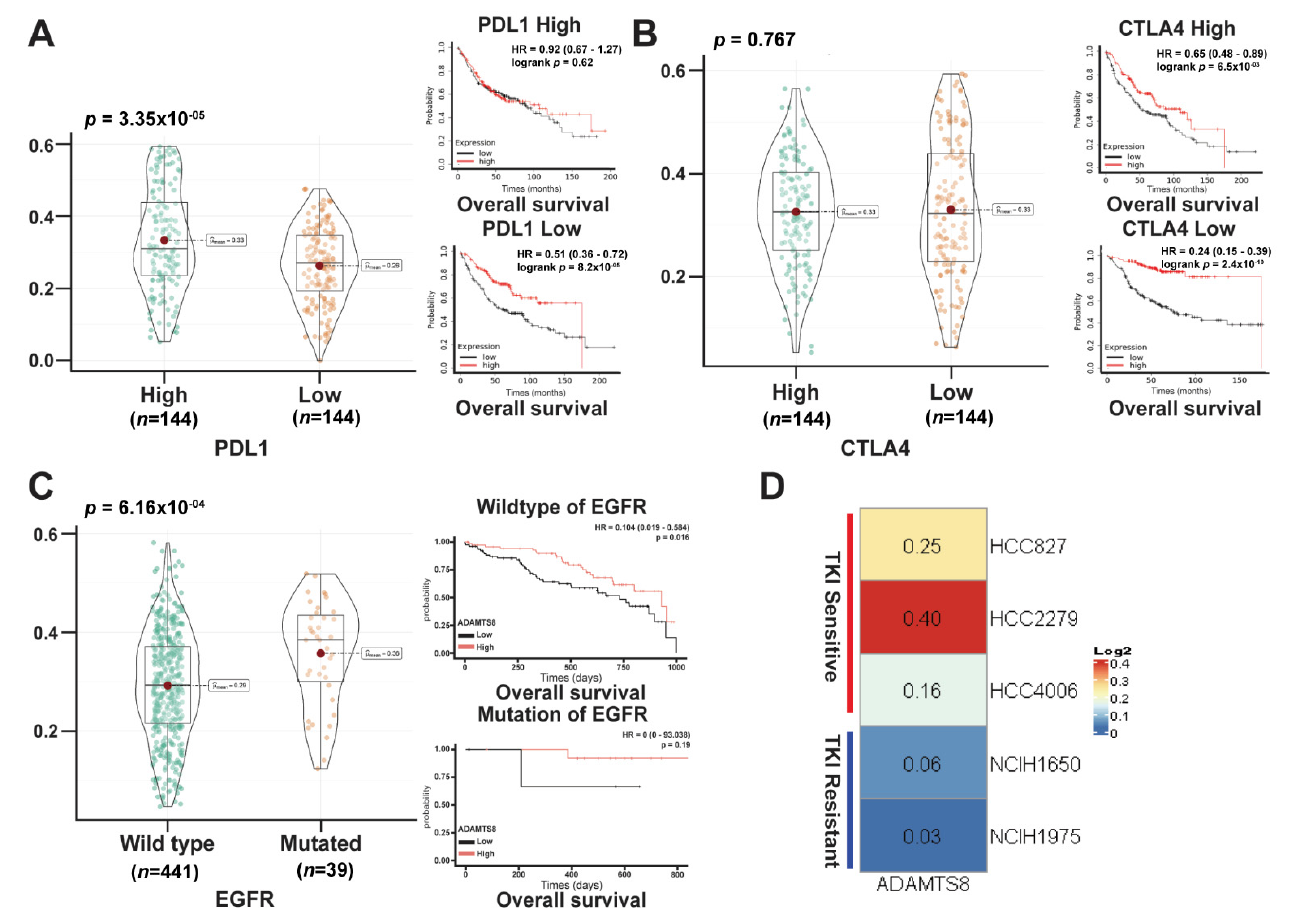
Figure 7. Patients with low PD-L1 expression or no driver mutations would benefit from ADAMTS8 treatment. The expression levels of ADAMTS8 are listed based on PD-L1 (CD274) expression (left panel, A ). The survival analysis of high versus low ADAMTS8 expression divided by high and low expression of PD-L1 showed a benefit of ADAMTS8 in patients with low PD-L1 but not high PD-L1 (mid, right panels, A ). CTLA4 showed a survival benefit regardless of levels of expression in CTLA4 ( B ). Regarding a targetable gene, EGFR, patients harboring the wild-type mutations but not common mutations with high-level ADAMTS8 survived longer ( C ). The expression of ADAMTS8 in various LUAD cancer cell lines ( D ).